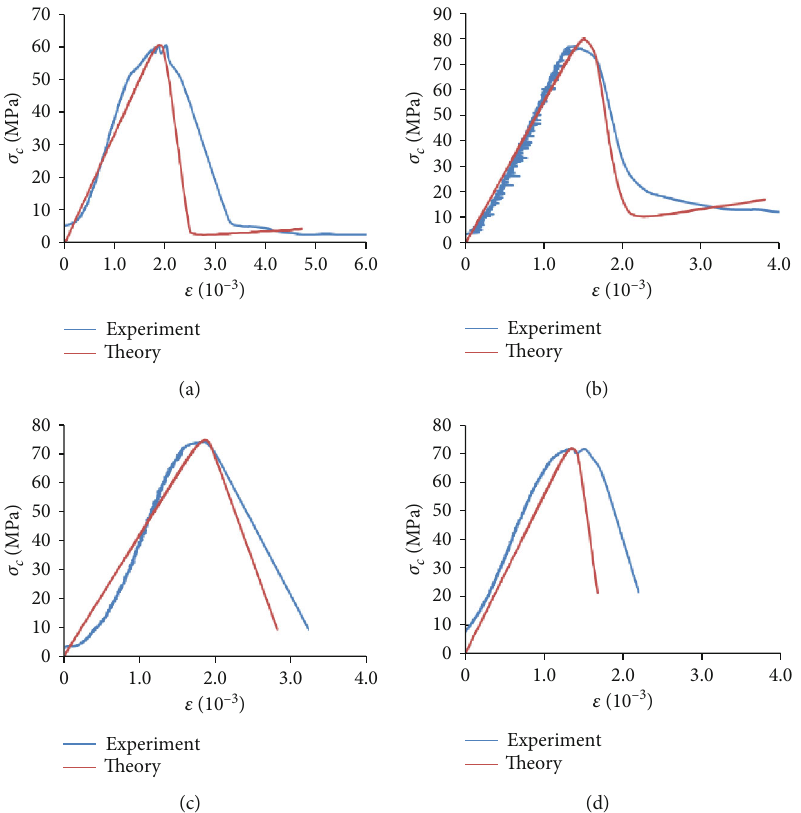
Figure 4: Experimental and theoretical curves of stress-strain of concrete with composite admixture under 30 (a), 110 (b), 190 (c), and 270 (d) days of corrosion after 60 freeze-thaw